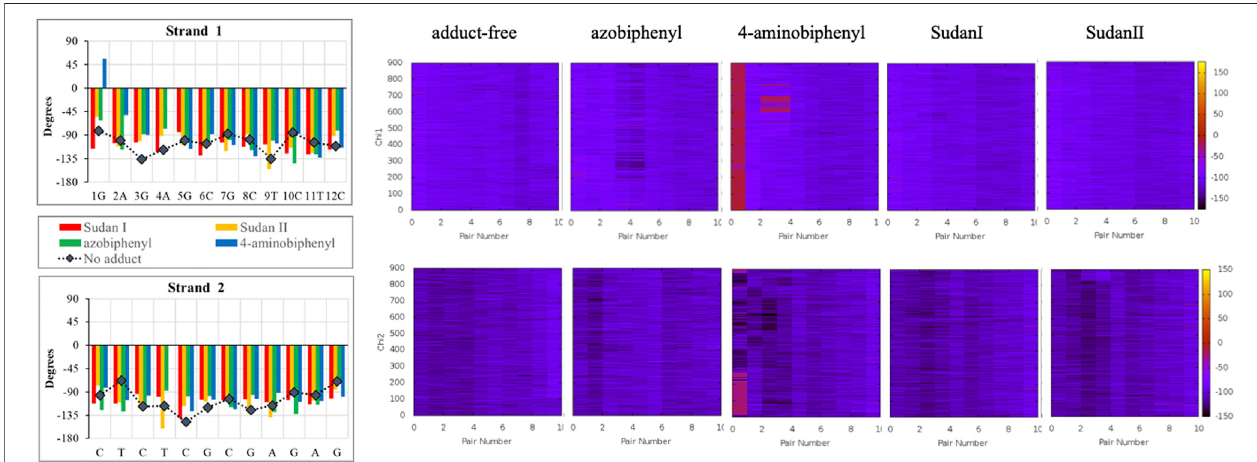
FIGURE 6 | The χ angle variation in the unaltered DNA dodecamer (black lines) for each strand in the double helix after 100 ns of MD simulations and how those anglesvaried upon adduct formationwithSudan I(red), SudanII(orange),azobiphenyl (green),and 4-aminobiphenyl(blue).The heatmapsillustratethechangesinthe χ angleoneachoftheDNAstrandsoverthe1 µstrajectory.Intheheatmaps,thez-axis(onthescaleontheright)representsthe χ anglemeasurementindegrees,andthe y-axis (on the left) represents the time in ns. The base pair number is across the x-axis.